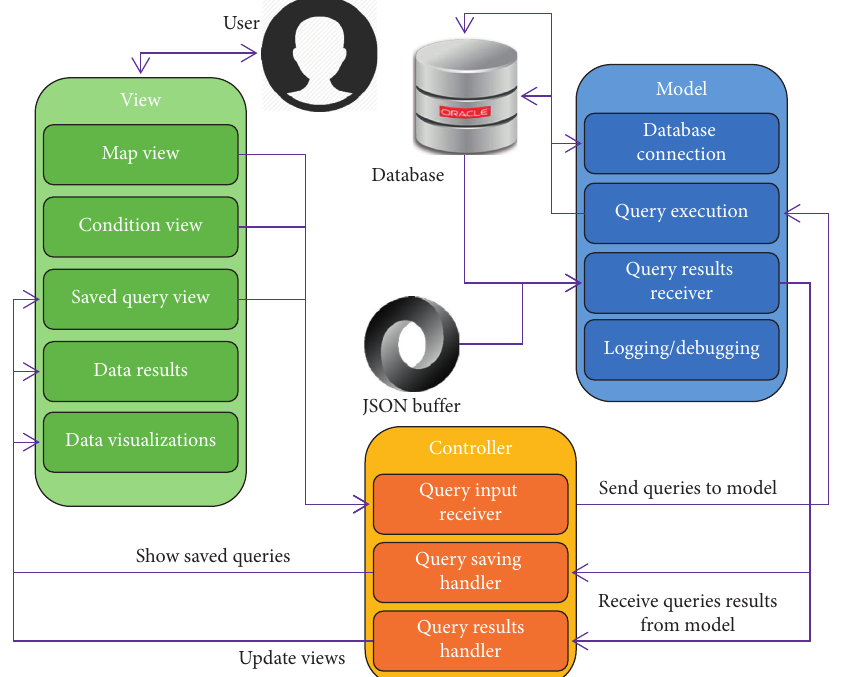
Figure 3: MVC structure of the